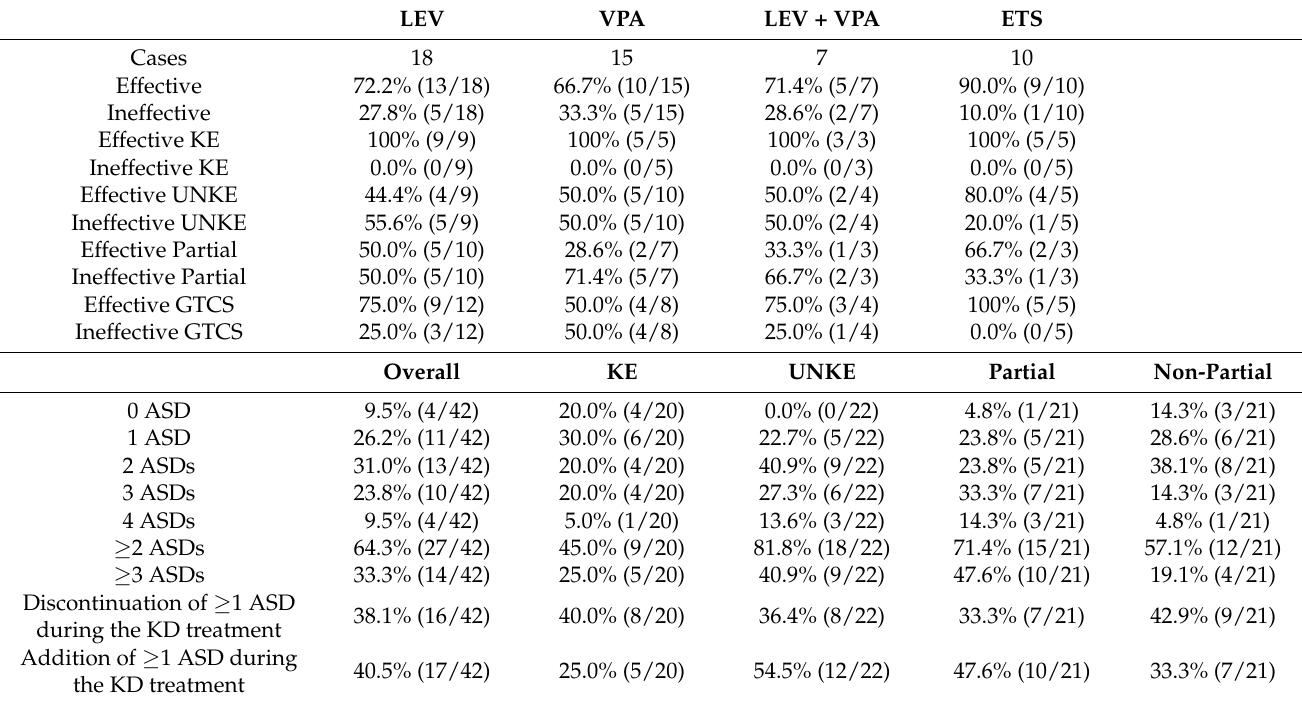
Table 5. Presentation of most commonly used anti-seizure drugs and number of them in spe- cific